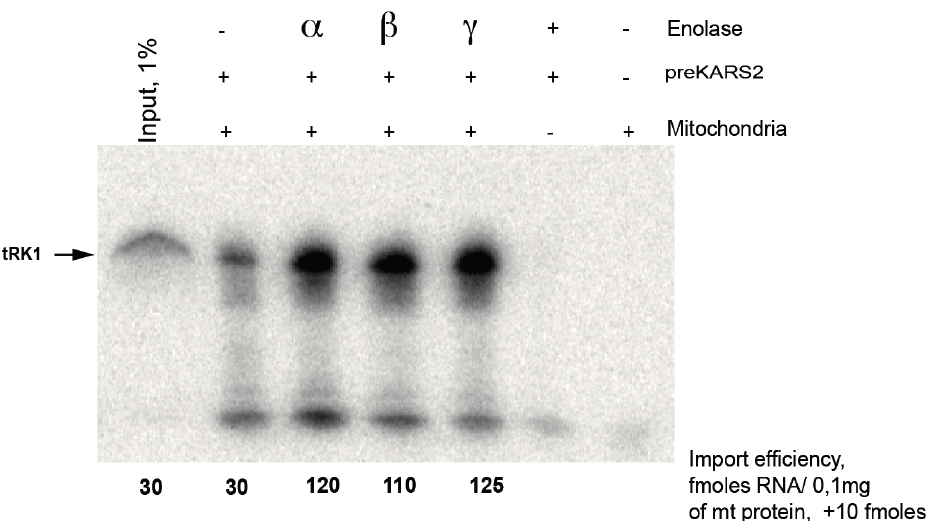
Figure 3. Import of tRK1 into isolated HepG2 mitochondria. An example of the in vitro import test, autoradiograph of RNA isolated from purified mitochondria and separated in denaturing 12% polyacrylamide gel (PAAG) is presented. The full-size RNA is indicated by an arrow at the left. Input, 1% of RNA used for each assay (as indicated above the lane), corresponding to 30 fmoles of labeled RNA. Mitochondria (+) correspond to the import assay, Mitochondria ( − ) to the mock import assay without mitochondria, used as a control for non-specific protein-RNA aggregation. The RNA import efficiency was calculated by comparing the signal with the input and indicated below each lane. One example from three independent experiments is presented, ±SD